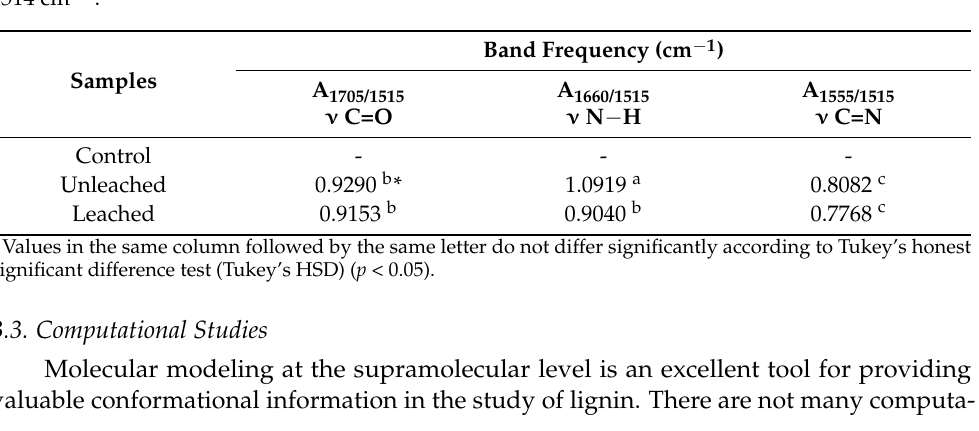
Table 3. Average value of relative absorbance of wood samples. All values were normalized to 1514 cm − 1